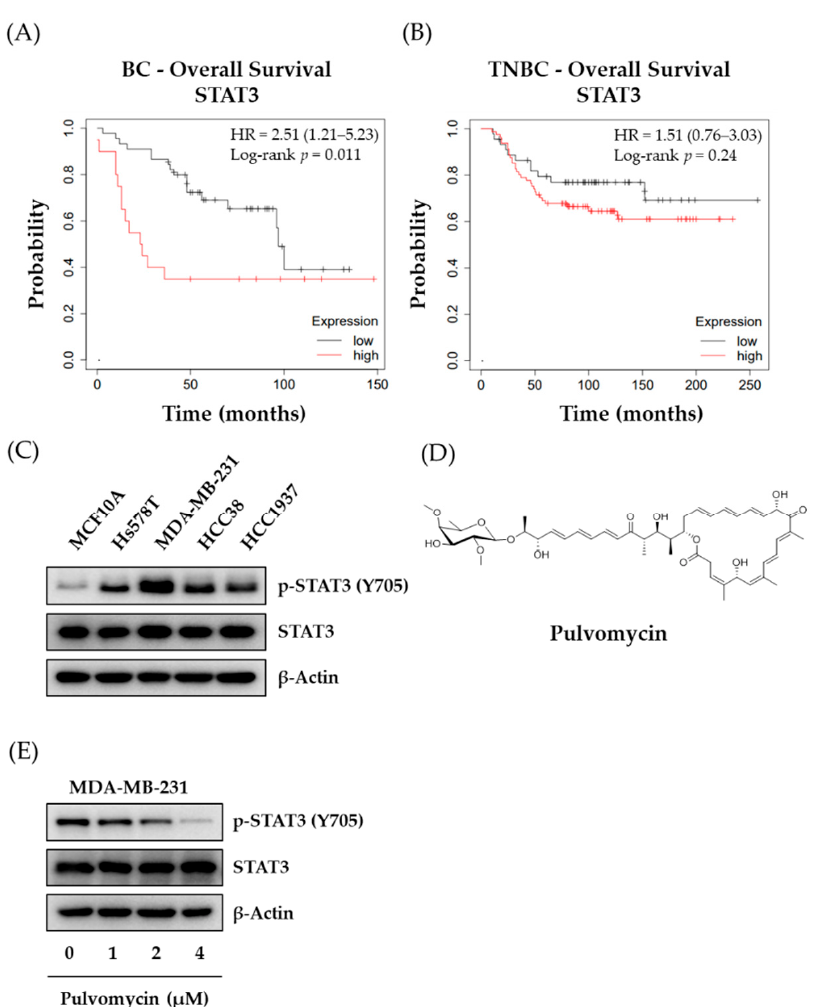
Figure 1. Relationship between signal transducer and activator of transcription 3 (STAT3) expression and overall survival (OS) in breast cancer, and the effect of pulvomycin on p-STAT3 in MDA-MB-231 cells. ( A ) The Kaplan–Meier survival curve for breast cancer-associated OS with STAT3 expression. ( B ) The Kaplan–Meier survival curve for TNBC-associated OS with STAT3 expression. ( C ) Levels of p-STAT3 expression in several TNBC cell lines were analyzed using Western blot analysis. β -Actin was used as an internal control. ( D ) Chemical structure of pulvomycin ( E ) MDA-MB-231 cells were treated with the indicated concentrations of pulvomycin for 24 h, and levels of p-STAT3 (Y705) and STAT3 expression were determined using Western blot analysis. β -Actin was used as an internal control.